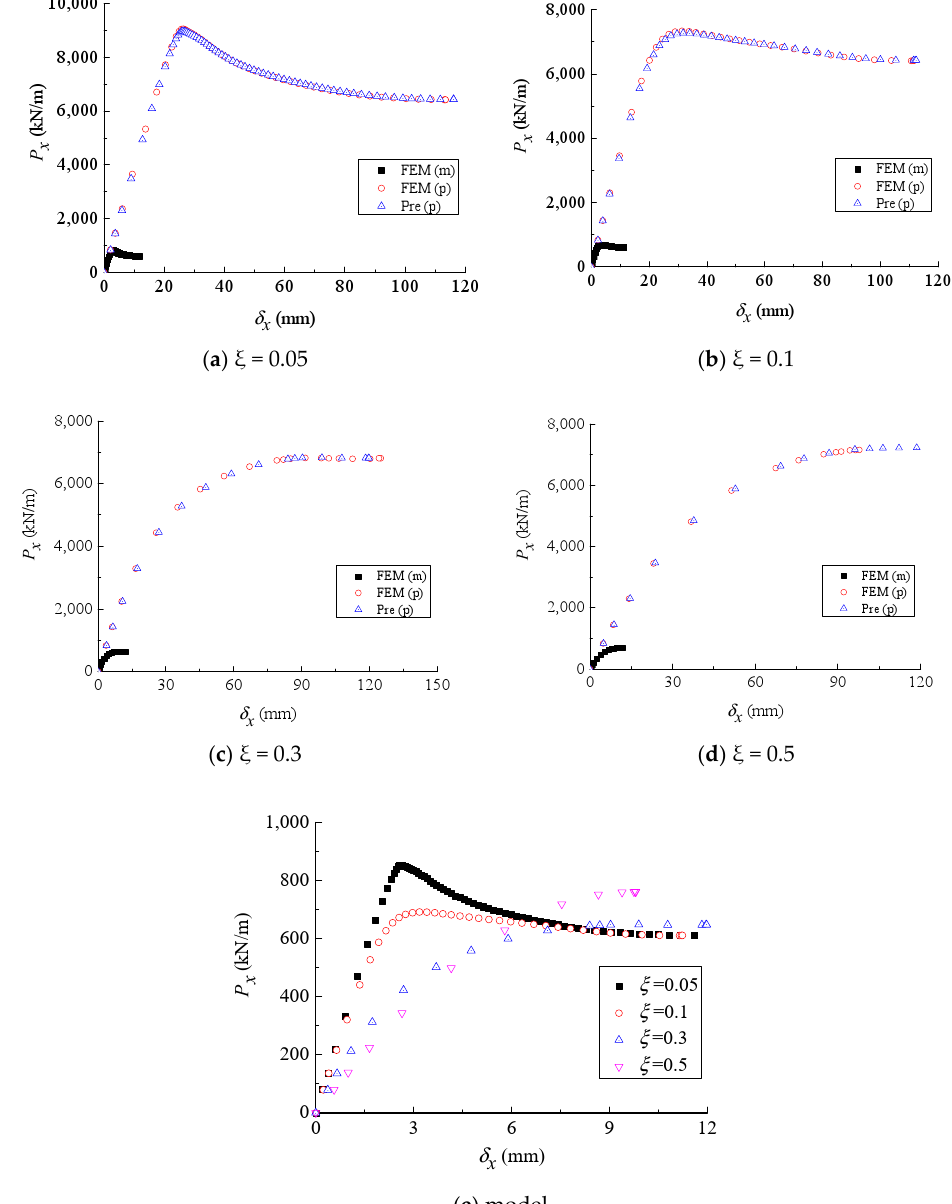
Figure 4. Comparison of the predicted and original load vs. end-shortening curves of the stiffened cylindrical shells with L / R = 2.51 and the SS3 boundary condition when the material of the model is AL.